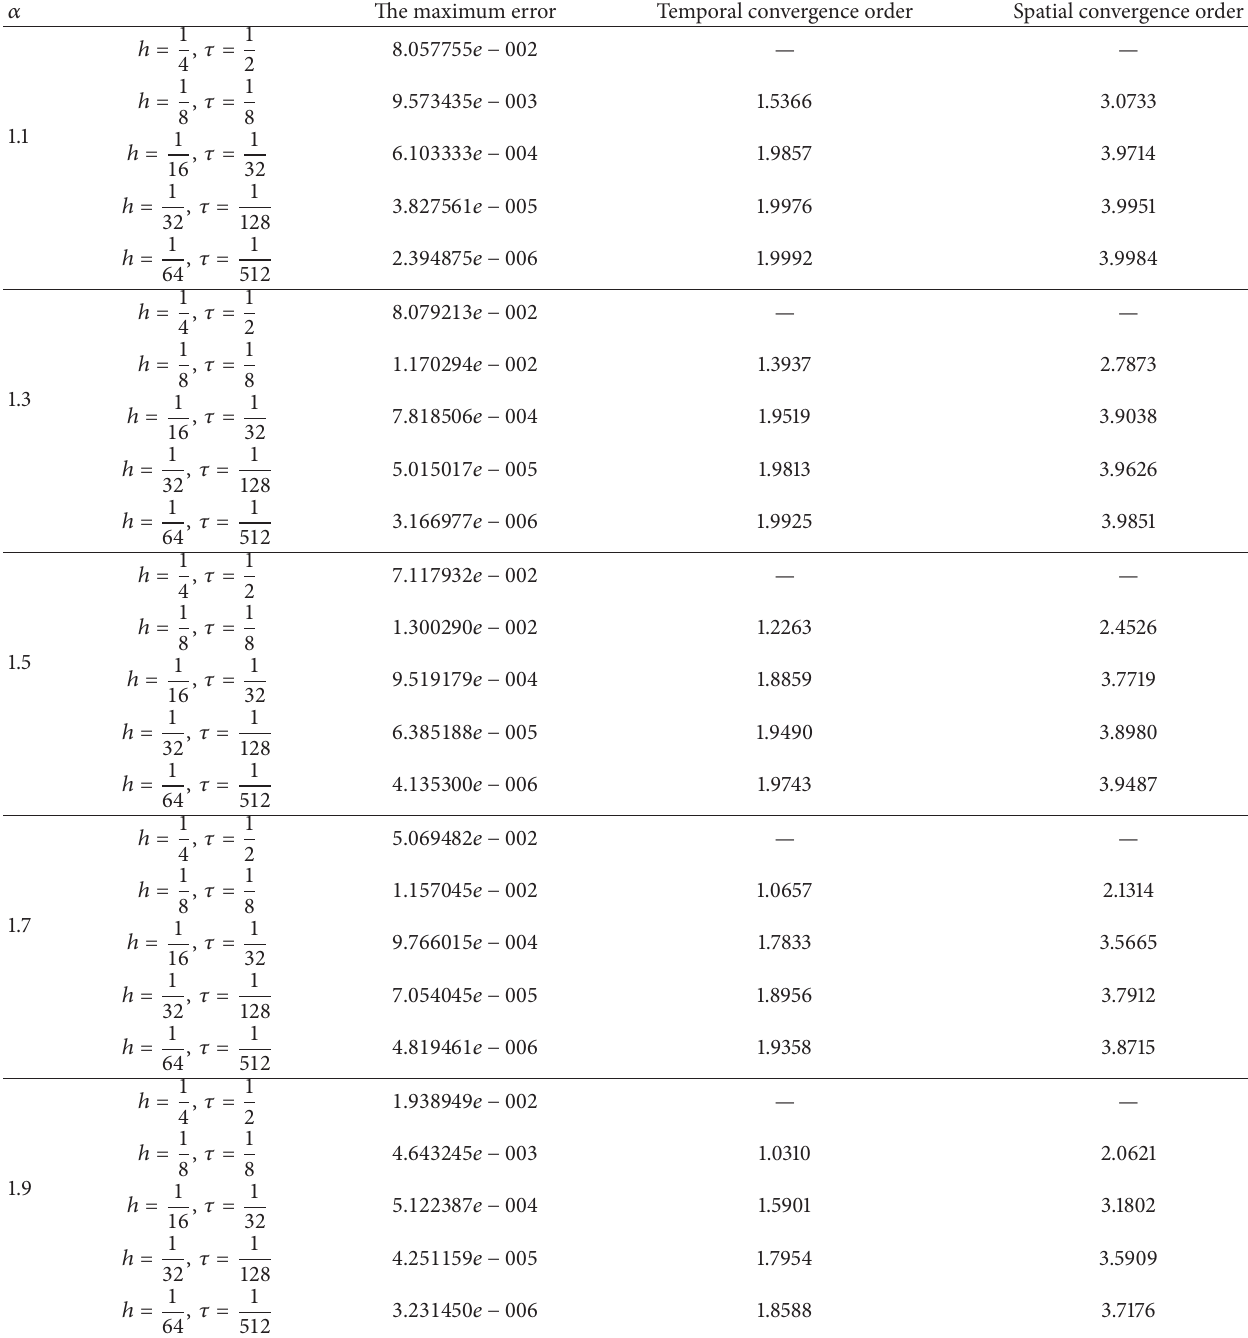
Table 1: The maximum error and temporal and spatial convergence orders by Numerical Algorithm I (see (38)).